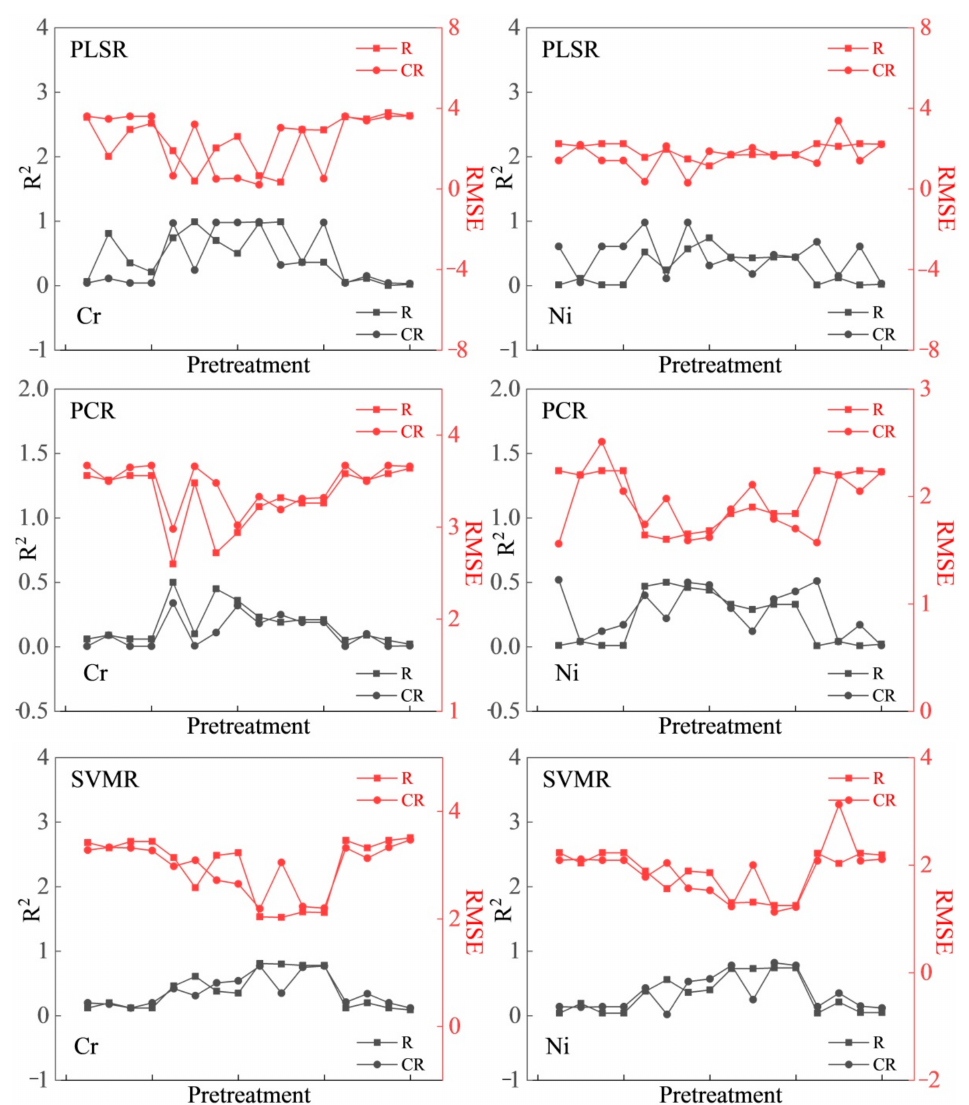
Figure 4. Determination effect of chromium (Cr, mg/kg) and nickel (Ni, mg/kg) elements based on the R and CR of spectral bands associated with